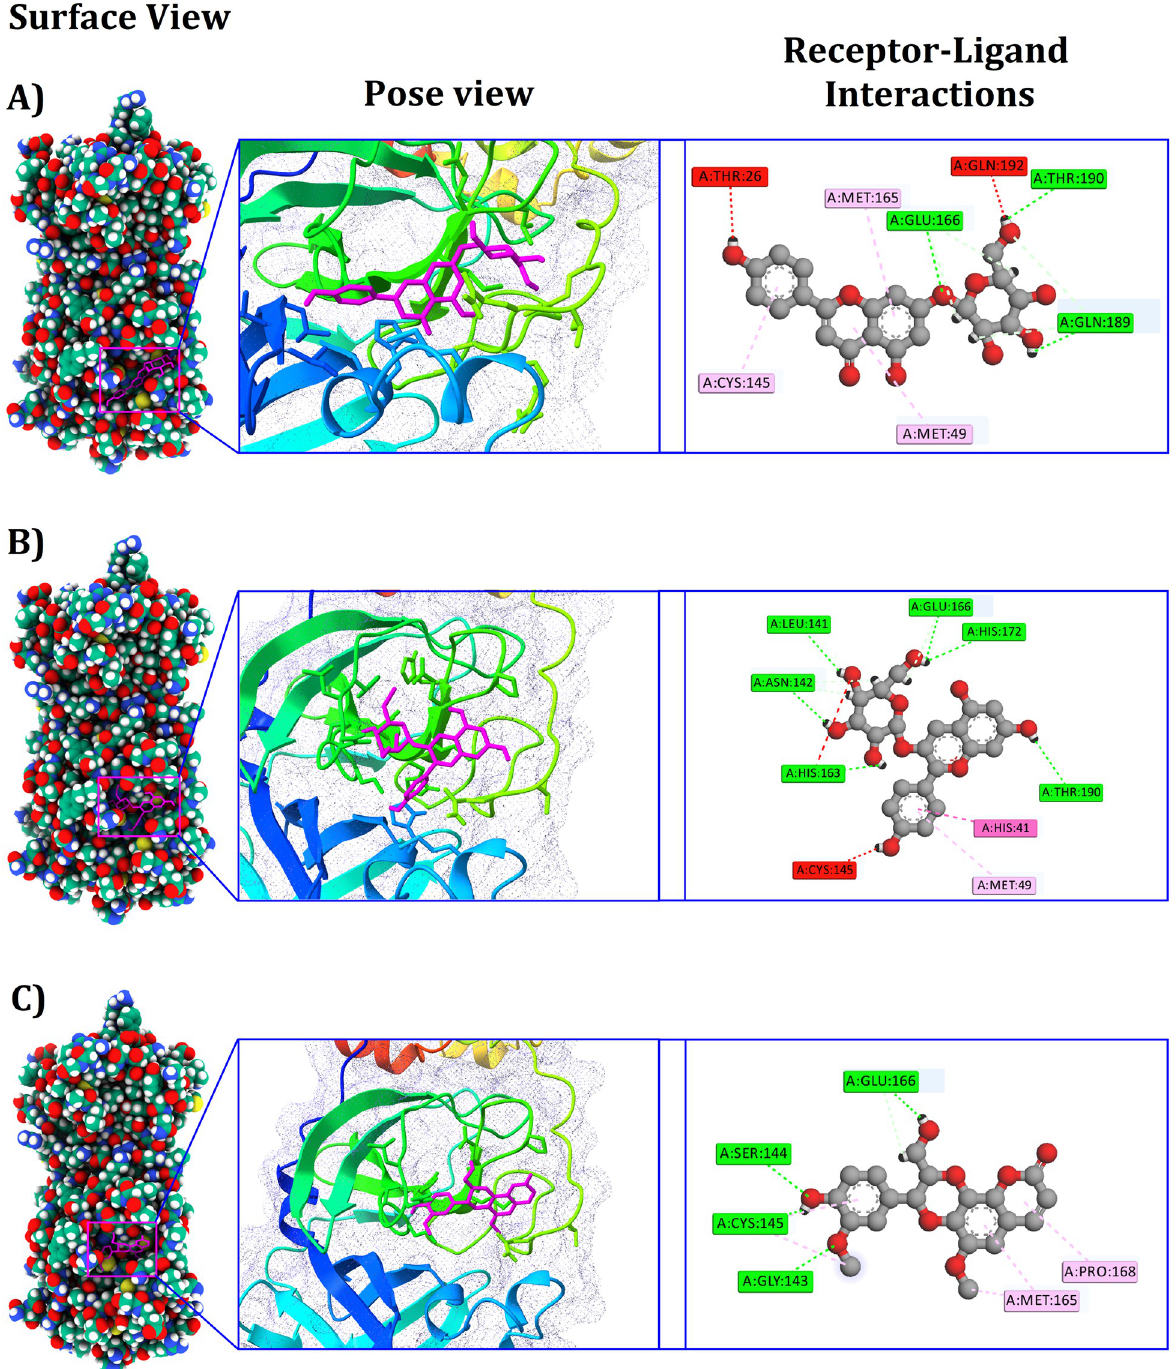
Fig 2. Illustration of the different binding modes of the selected compounds within the active and catalytic sites of the Mpro. The alphabetical orders indicate the respective complexes of Cosmosiine, Pelargonidin-3-O-glucoside, and Cleomiscosin A, respectively. Cosmosiine interacted with Thr190, Gln189, Glu166, Met165, Met49, and Cys145; pelargonidin-3-O-glucoside with Glu166, His172, Leu141, Asn142, His163, Thr190, His41, and MET49, and Cleomiscosin with Cys145, Glu166, Gly143, and Ser144, Met165, Pro168 residues.